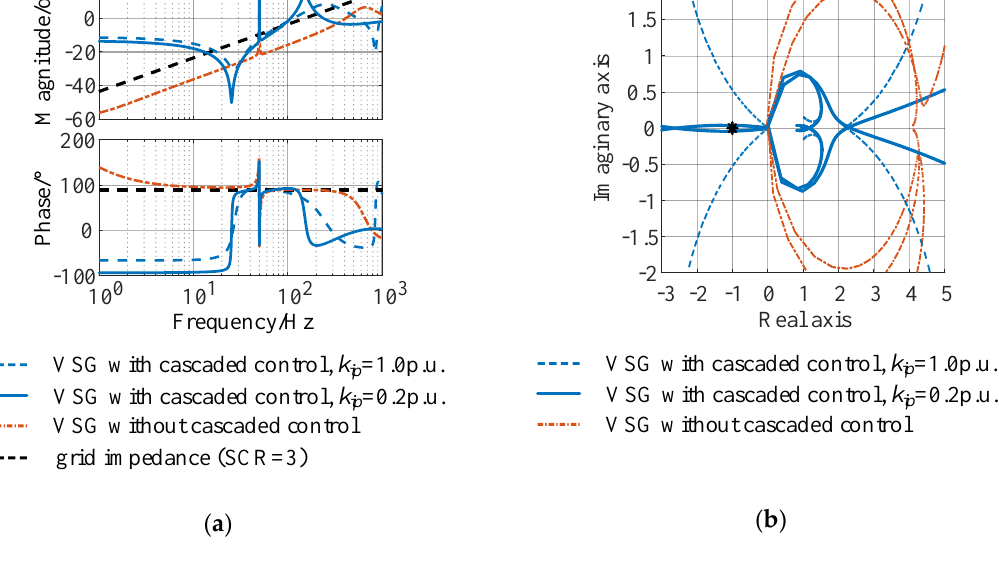
Figure 8. Stability of VSG controlled converters with the inductive weak grid: ( a ) impedance characteristics; and ( b ) Nyquist plot.